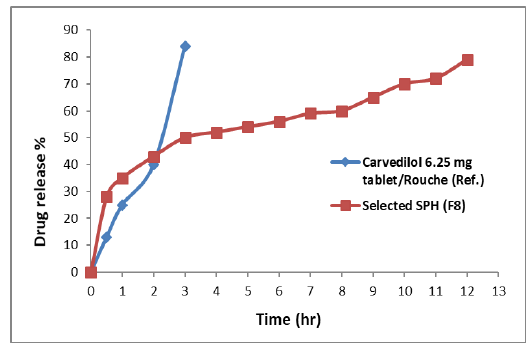
Figure 3. Dissolution profile of carvidelol tablet/Roche and selected SPH (F8) Fourier Transform Infrared (FTIR)- Compatibility study